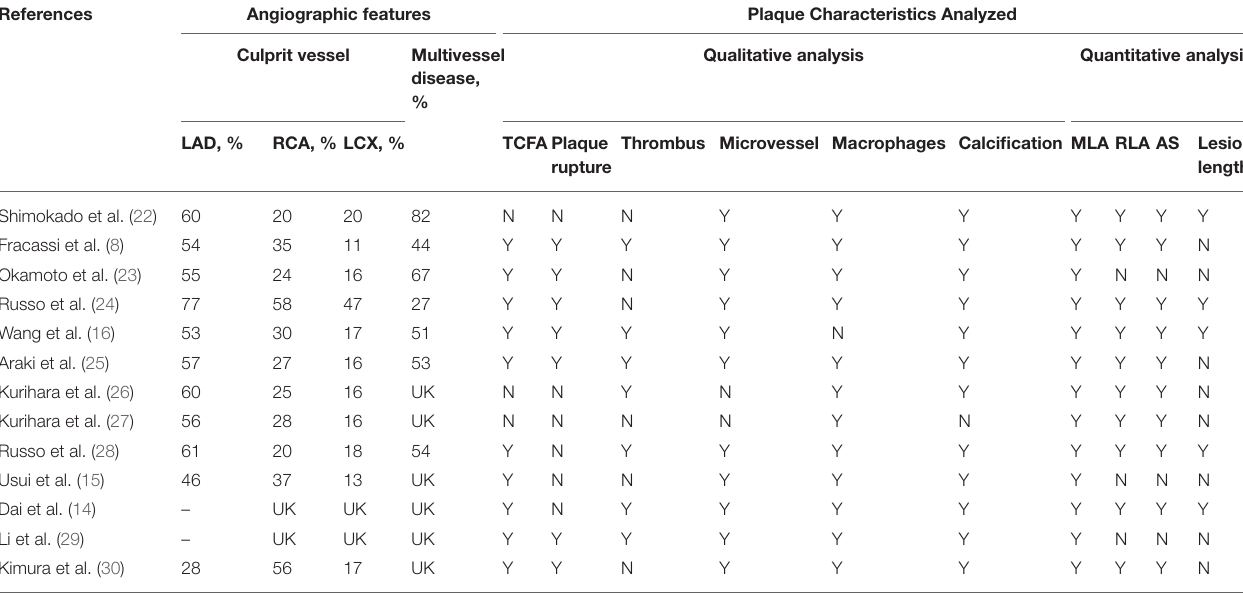
TABLE 3 | Angiographic features and OCT-derived plaque characteristics.